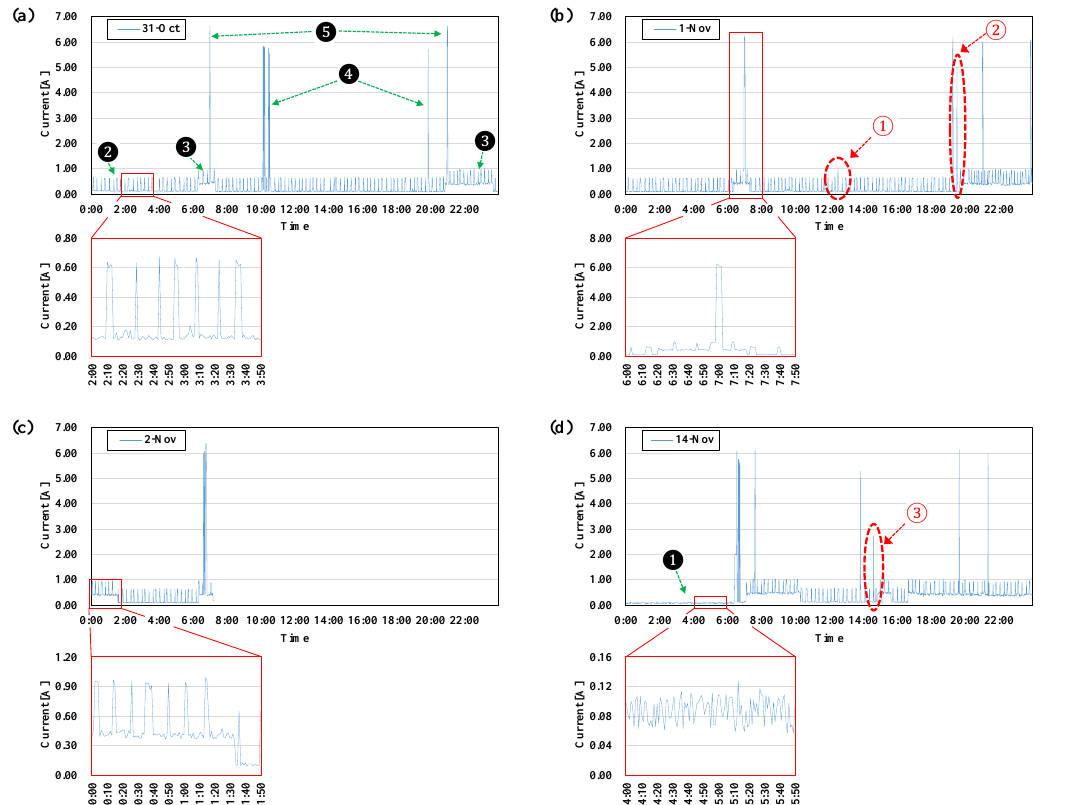
Figure 5. Current data for the operation of LT, REF, TV, and MW: ( a ) 31 October; ( b ) 1 November; ( c ) 2 November; ( d ) 14 November. Table 4. Usage patterns of appliances.